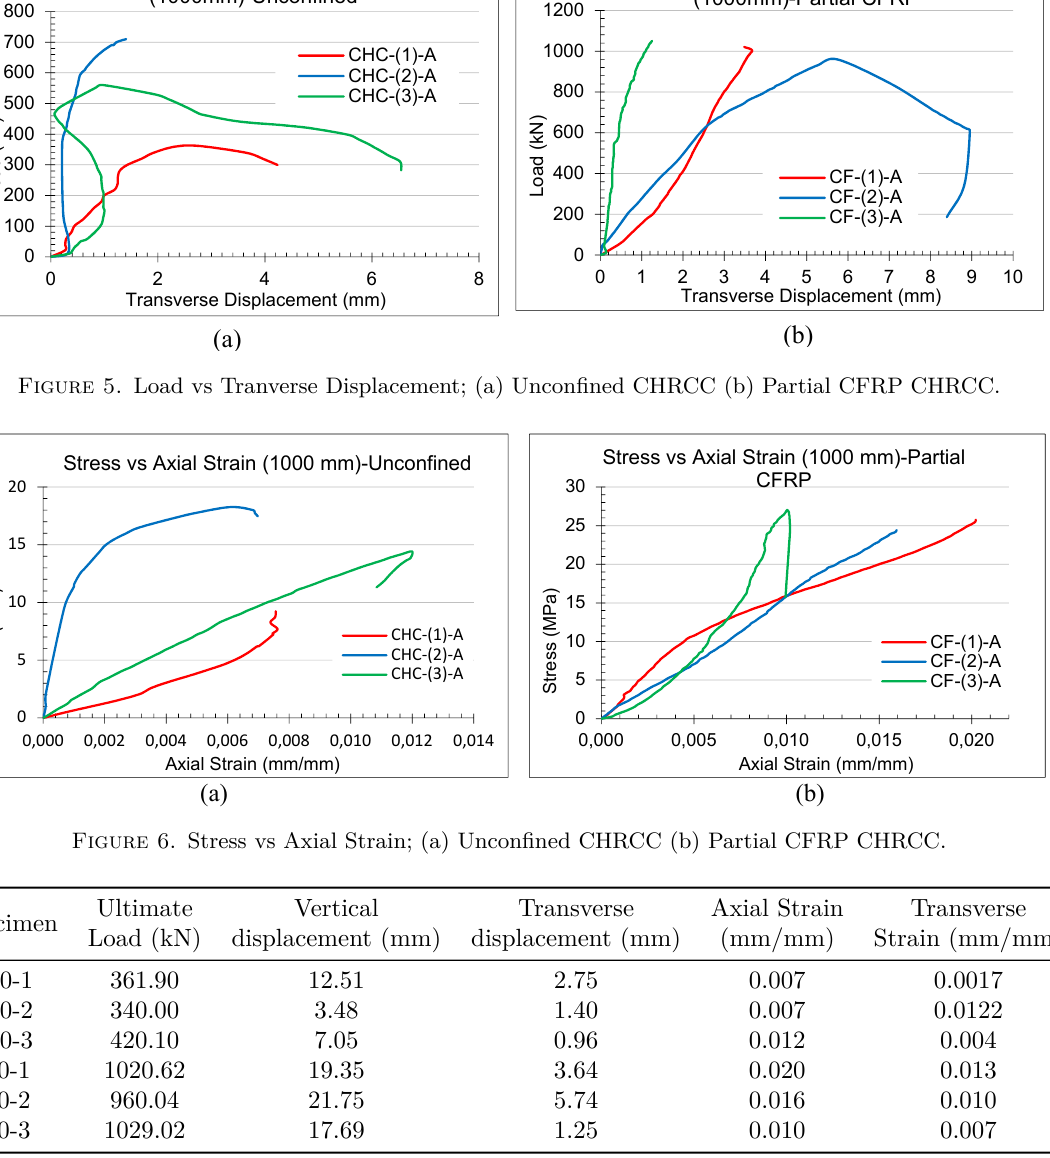
Table 2. Summary of Test